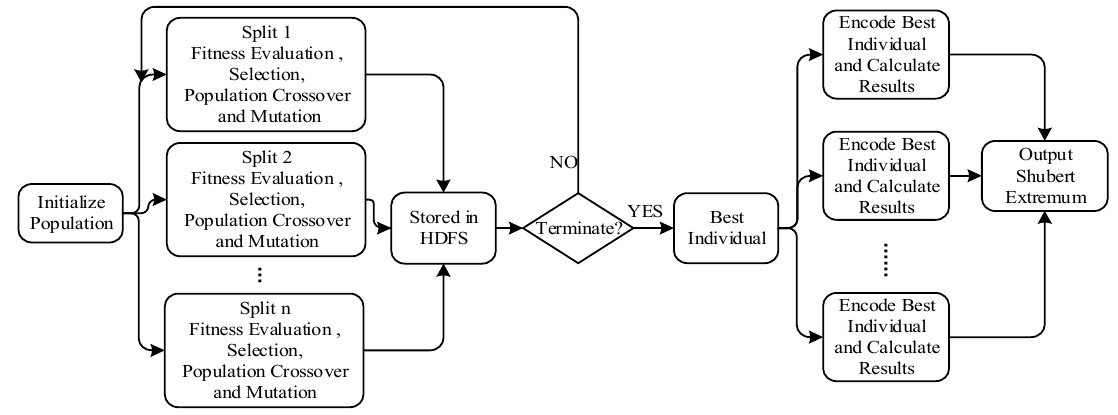
Figure 4. Hadoop-based parallel GAESMPF.